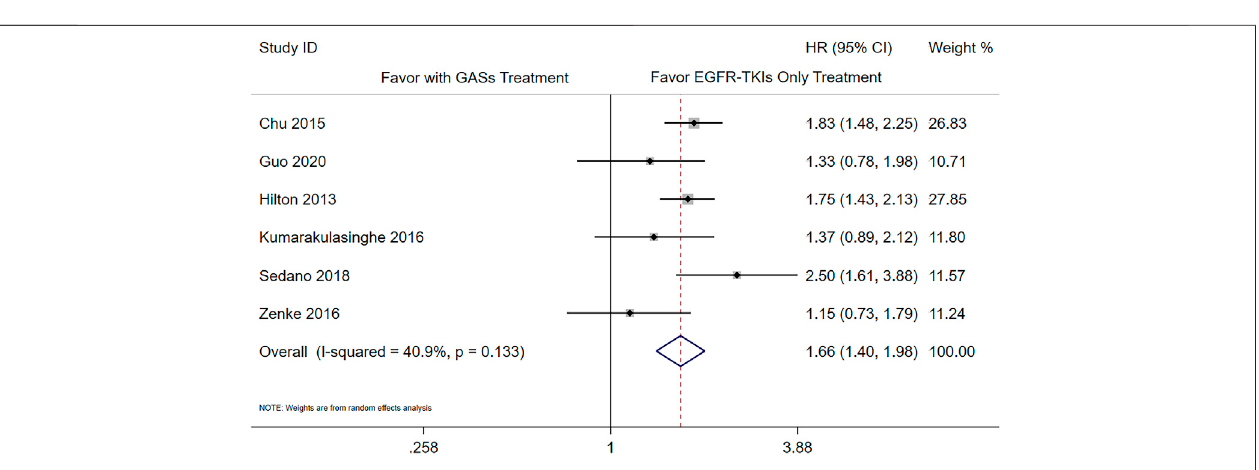
Frontiers in Pharmacology |